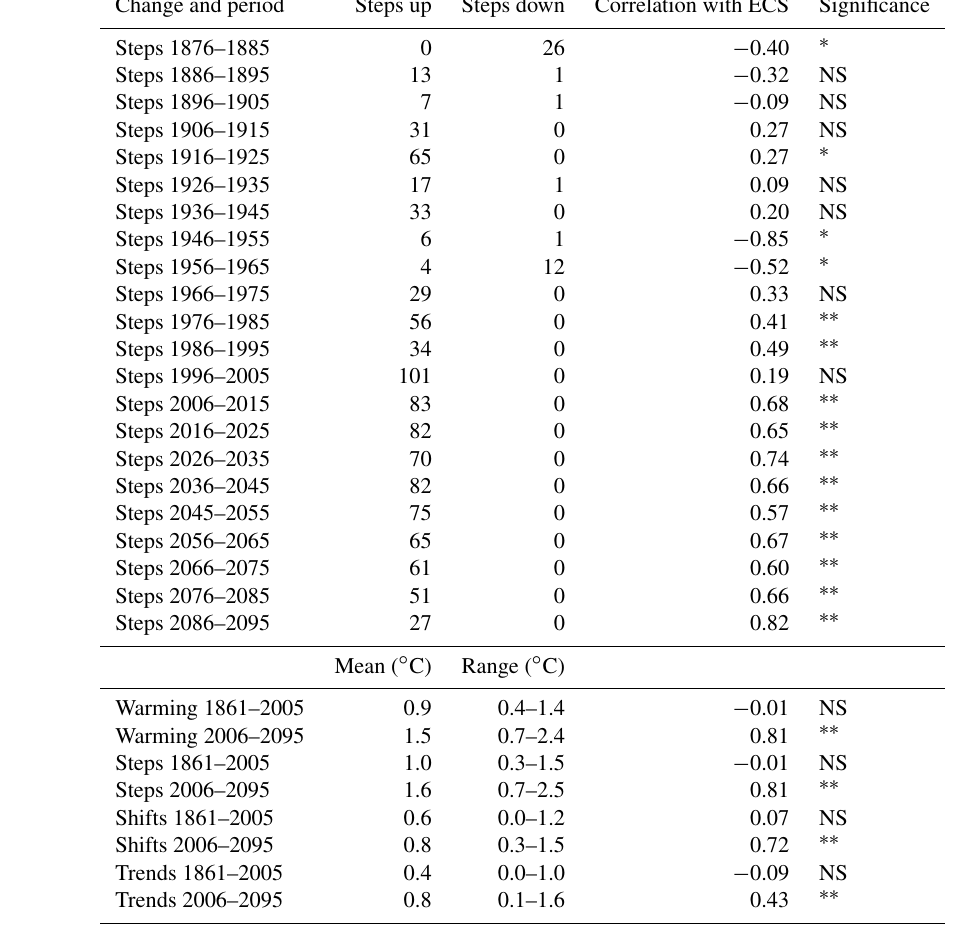
Table 3. Steps collated for each decade from 1876 to 2195 from the RCP4.5 MME, showing total steps up and down and the correlation between step size and ECS. The second part of the table shows the correlations between total warming, steps and trends over the observed and simulated periods and ECS. Correlations are classified as not significant (NS, p >0.05), p <0.05 ( ∗ ) and p <0.01 ( ∗∗ ). Total correlations with the MME are n = 107 and with ECS are n = 92. Change and period Steps up Steps down Correlation with ECS